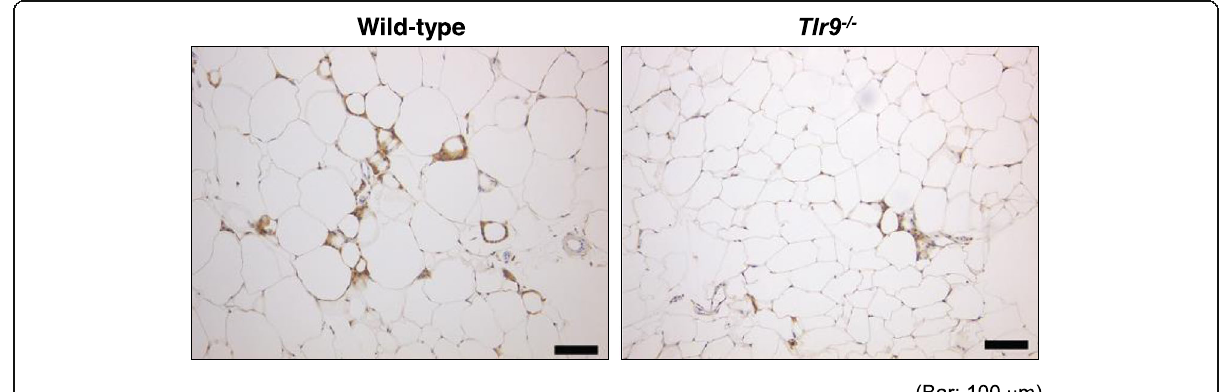
Fig. 3 Genetic deletion of TLR9 attenuated obesity-induced adipose tissue inflammation. Representative figures of Mac3 staining of visceral adipose tissue from HFD-fed wild-type or TLR9-deficient mice. Genetic deletion of TLR9 reduced the accumulation of macrophages in adipose tissue, indicating less inflammation. Bar, 100 μ